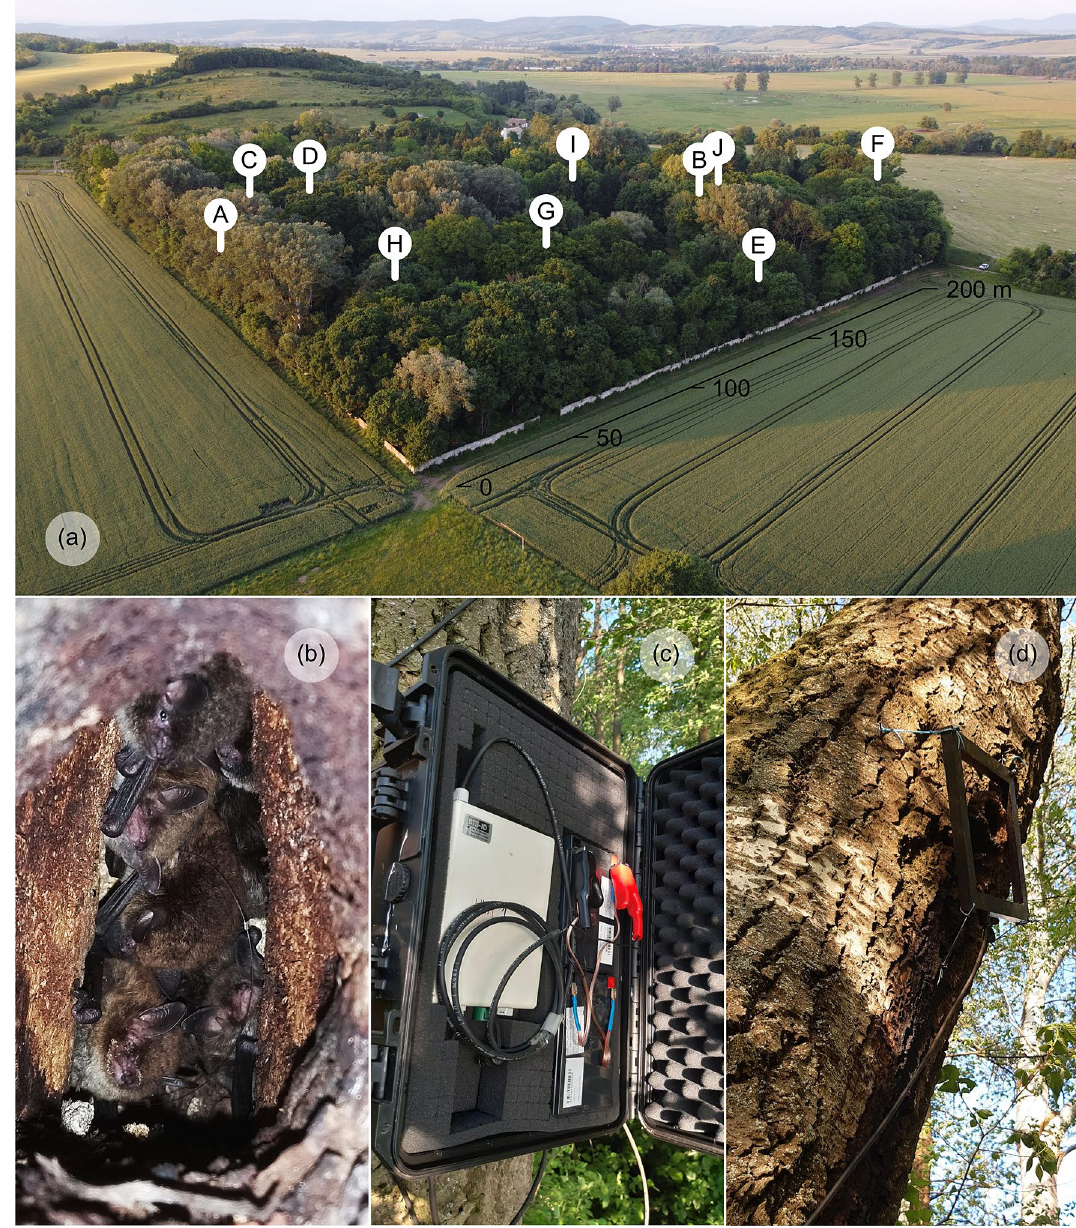
Figure 1. ( a ) The study area with locations of tree roosts of the Daubenton’s bat in an old park in southern Slovakia. ( b ) Maternity colony of Daubenton’s bats in a tree roost. ( c ) Automatic PIT tag reader protected by waterproof case with ( d ) square-shaped antenna placed over roost entrance (Photo by P. Ag317, weight 0.4 g; Biotrack/Lotek, Inc.) and located their roosts using TRX100 S3 receiver and a three-element hand-held directional Yagi antenna (Wildlife Materials, Inc.). Some roosts were opportunistically found during morning observations of swarming behaviour in the park; however, most were identified through radio-track- ing. Simultaneously, we made mist-netting sessions approximately twice a week on the commuting corridor, and all animals were labelled with individual identification codes by subcutaneous insertion of PIT tags (ID100 Mini Transponder, diameter 1.4 mm, length 8 mm; Trovan, Ltd.) in their scapular region 38 . In total, 389 bats were PIT-tagged in the area. Along with PIT-tagging we installed automatic PIT tag readers (BTS-ID, Sweden; Fig. 1c) on altogether 10 bats roosts in tree hollows during three consecutive seasons from May 2019 to early September 2021. The number of monitored roosts differed between seasons according to our knowledge about their occupancy by adult females and their offspring (4 roosts were successfully monitored in 2019, 8 in 2020 and 7 in 2021). The PIT tag readers antennas placed over roost entrances were square-shaped and measured 30 × 30 cm (Fig. 1d). Due to technological limitations, this approach may not provide accurate determination of all displays of swarming behaviour, which is mainly performed around the tree outside the distance recordable with antennas; however, it can provide reliable summary measures of most events (landings, leaps, crawling,